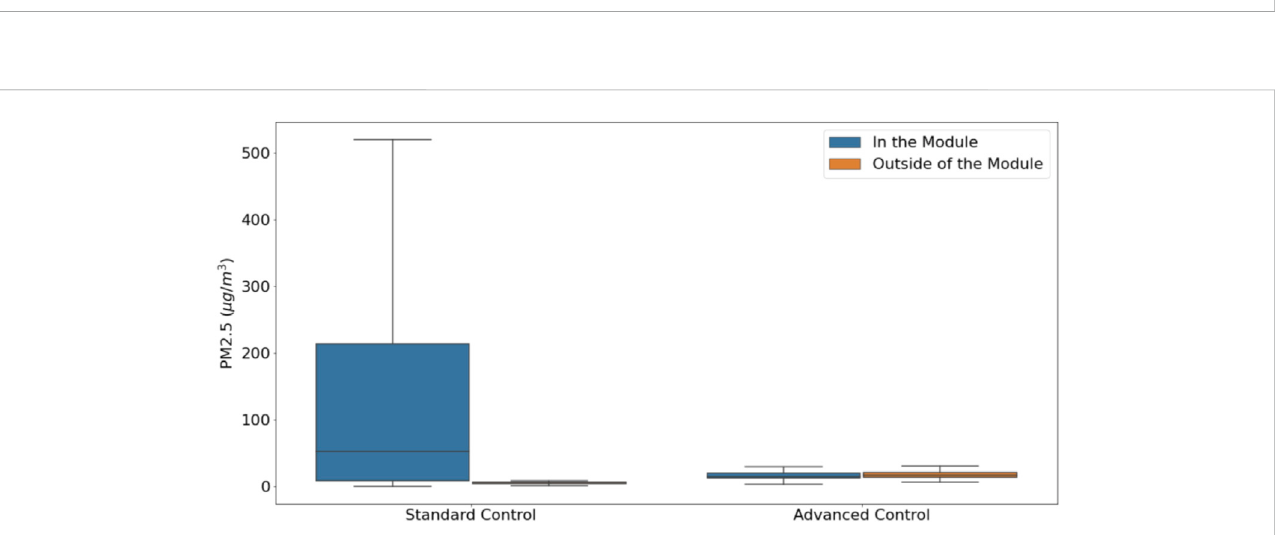
FIGURE 7 Average concentration participants were exposed to during the day in standard and advanced controlled residential